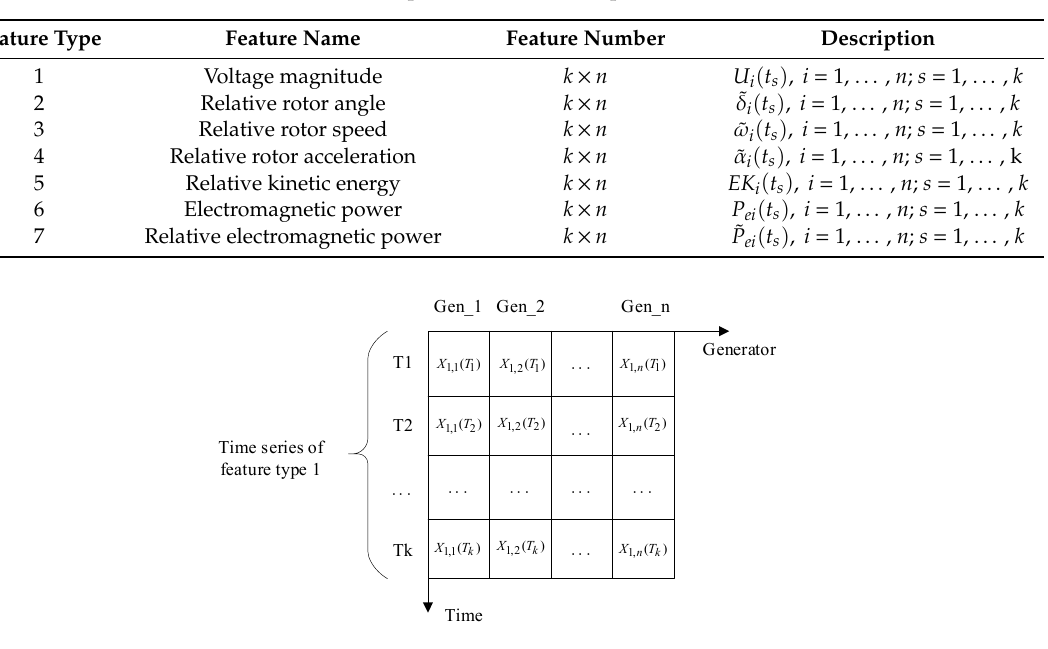
Table 1. Descriptions of di ff erent input features.